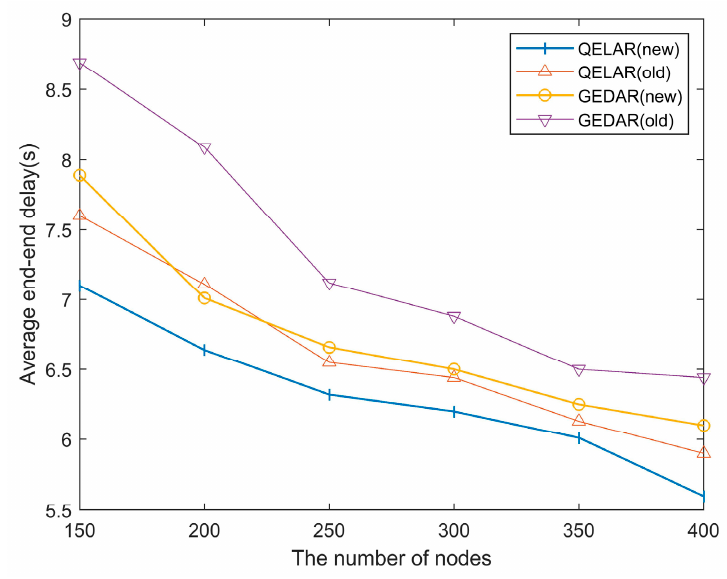
Figure 9. Comparison of average end-to-end delay for different architectures.